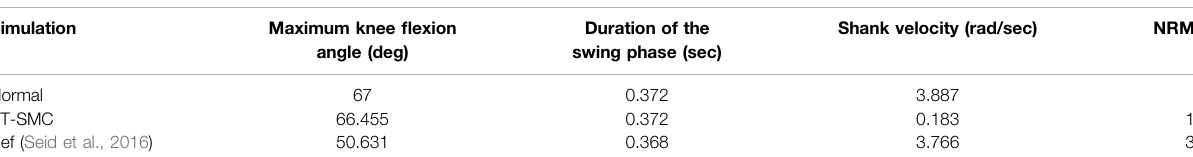
Duration of the swing phase (sec)